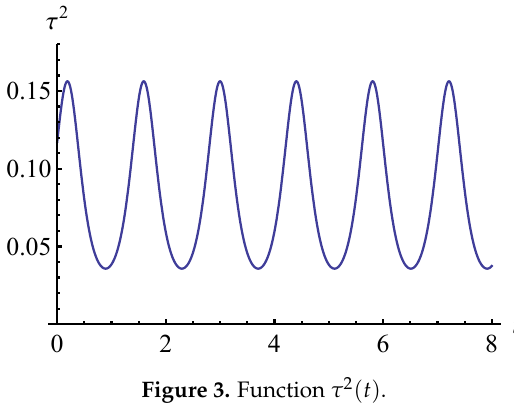
Figure 3. Function τ 2 ( t )